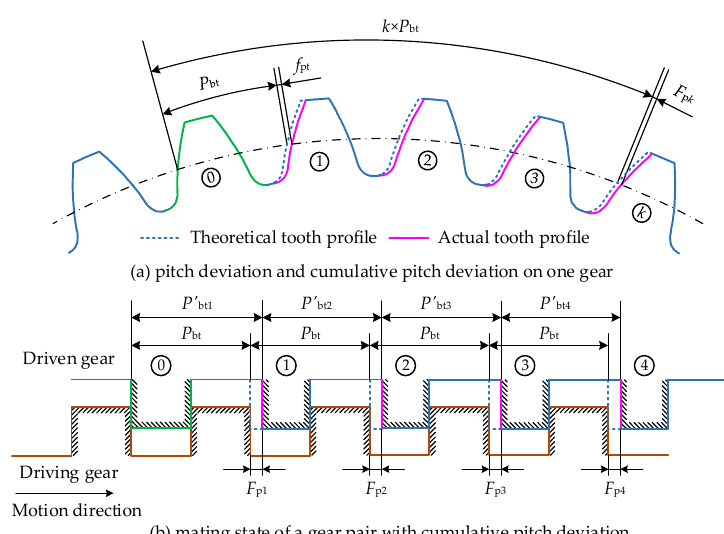
Figure 2. End-side view and mating state of helical gear pair with cumulative pitch deviations.